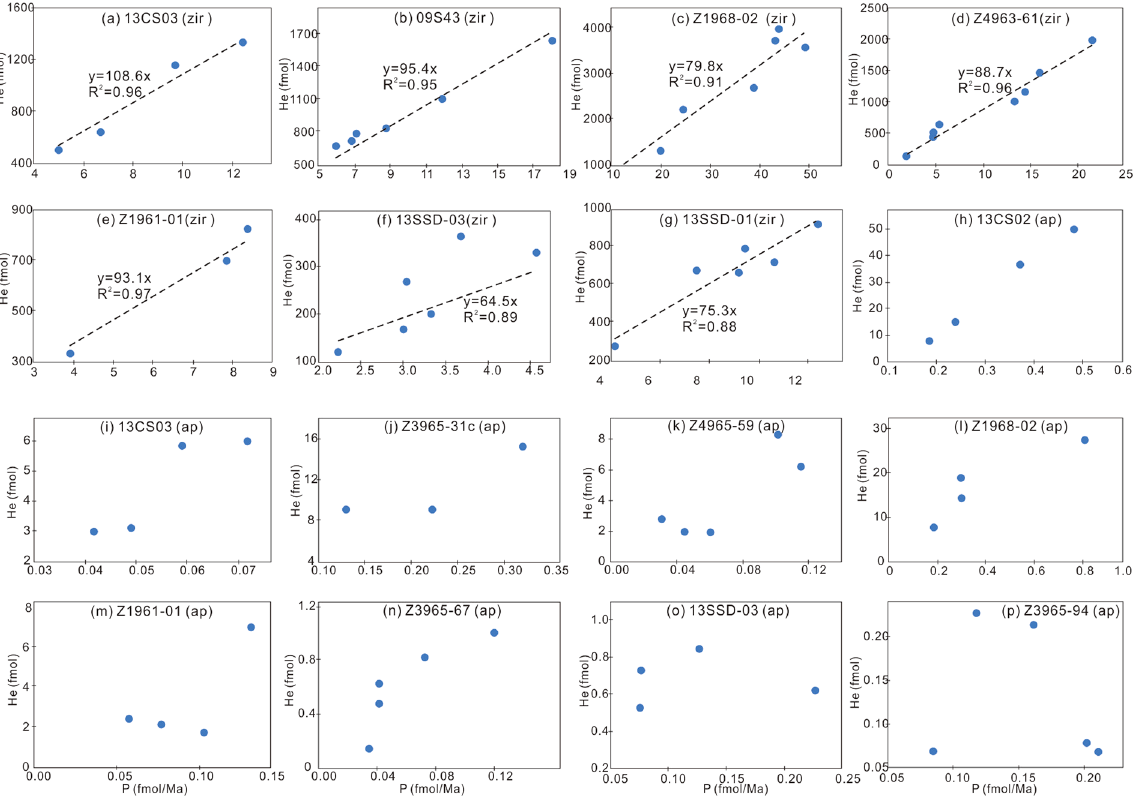
Figure 4. Plots of helium concentration versus production rate (P) for zircon and apatite from Sanshandao. zir: zircon; ap: apatite.